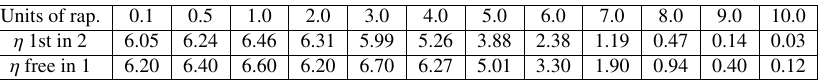
Table 2. Central pseudorapidity distribution for the same N ch Units of